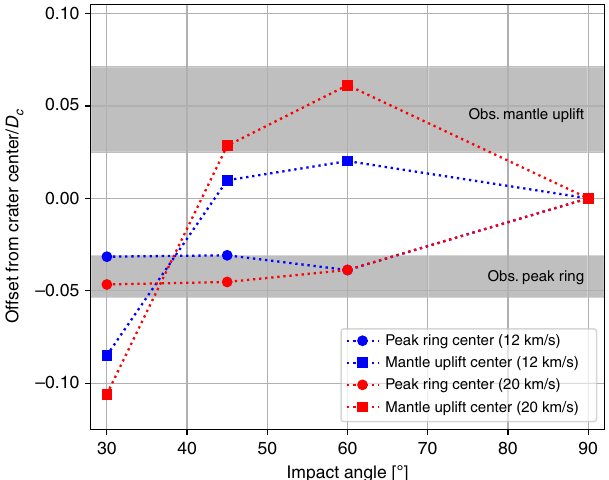
Fig. 5 Offset of structural crater features relative to crater centre. The offsets of the centre of mantle uplift (squares) and the centre of the simulated peak ring (circles), relative to the crater centre, are shown as a function of impact angle to the horizontal. Grey bands denote the approximate relative offsets of the peak-ring and mantle-uplift centres at Chicxulub, taking into account the uncertainty in crater diameter and locations of the different features (see Supplementary Fig.